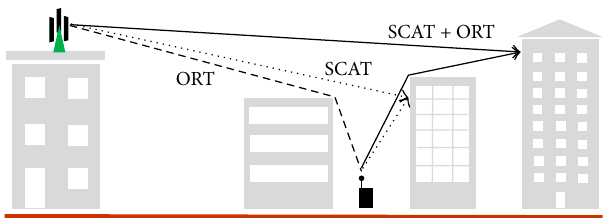
Figure 2: ORT model in the vertical plane and combination with